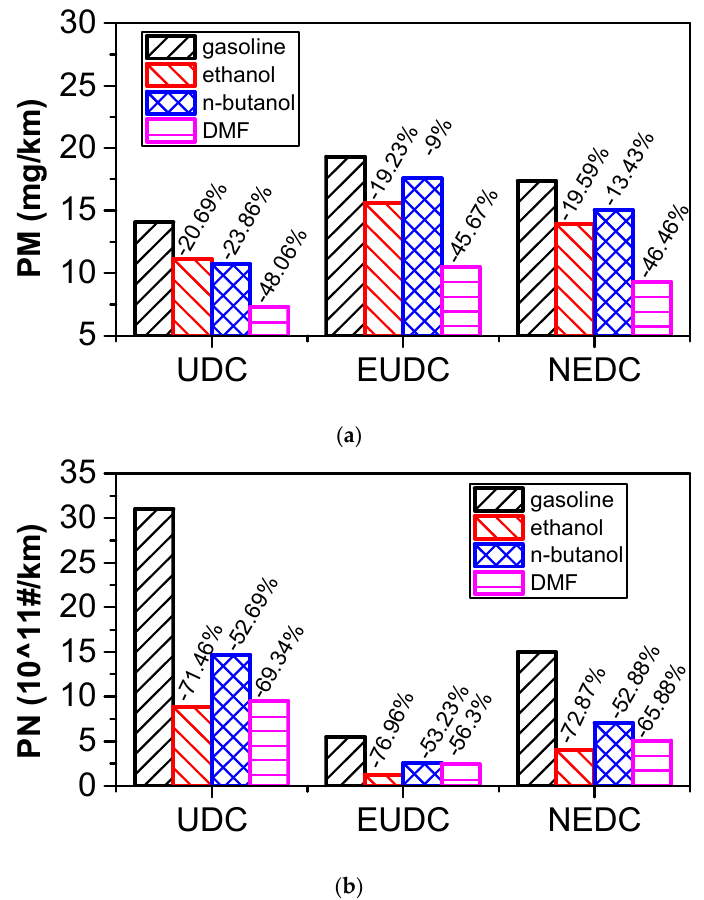
Figure 13. Comparison of particulate matter (PM) and particle number (PN) emissions of E20, B20, D20, and gasoline: (a) PM emissions; (b) PN emissions.